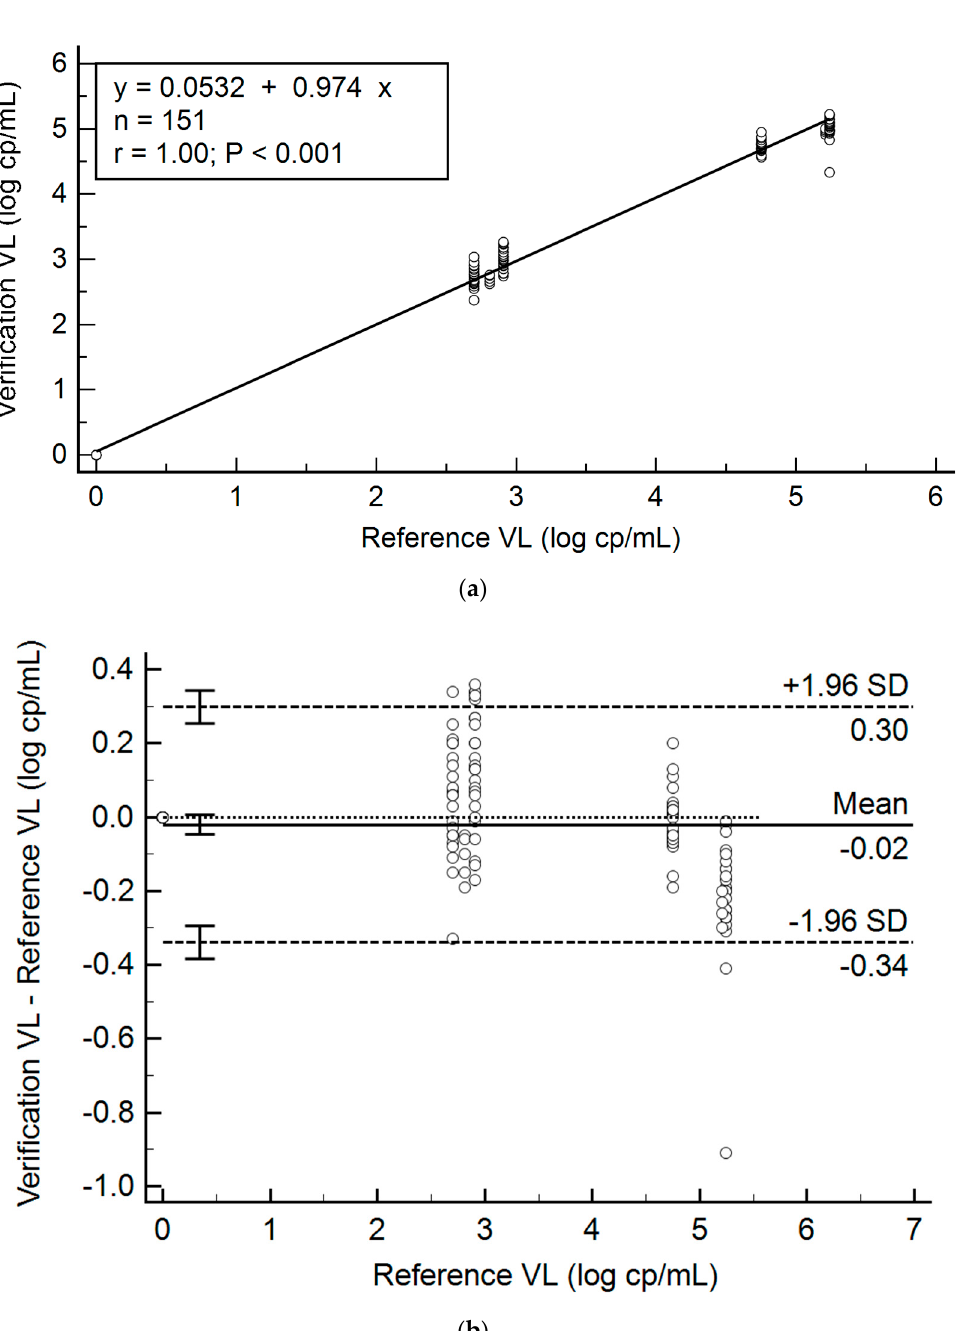
Figure 2. Verification panel VL variation (log cp/mL) across different testing sites (n = 13). ( a ) Regression analysis for all verification panels tested between September 2017 and November 2018. ( b ) Bland-Altman agreement of the viral load results, compared to the reference result obtained at panel preparation. One outlier specimen (4.33 log cp/mL; − 0.91 log cp/mL difference from reference VL) was noted in the 5.0 log cp/mL category, but was within the acceptable range for the pilot panels (<1.0 log cp/mL).VL: viral load. cp/mL: copies per milliliter. SD: standard deviation.